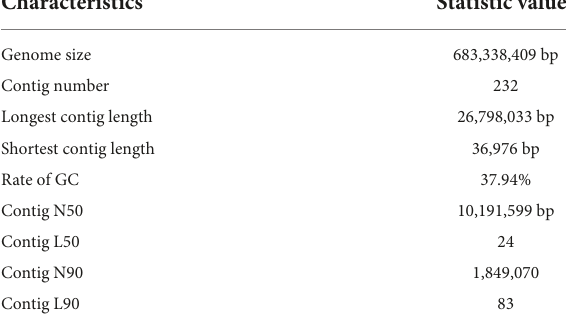
TABLE 1 Summary statistics of the genome assembly of L. taibai